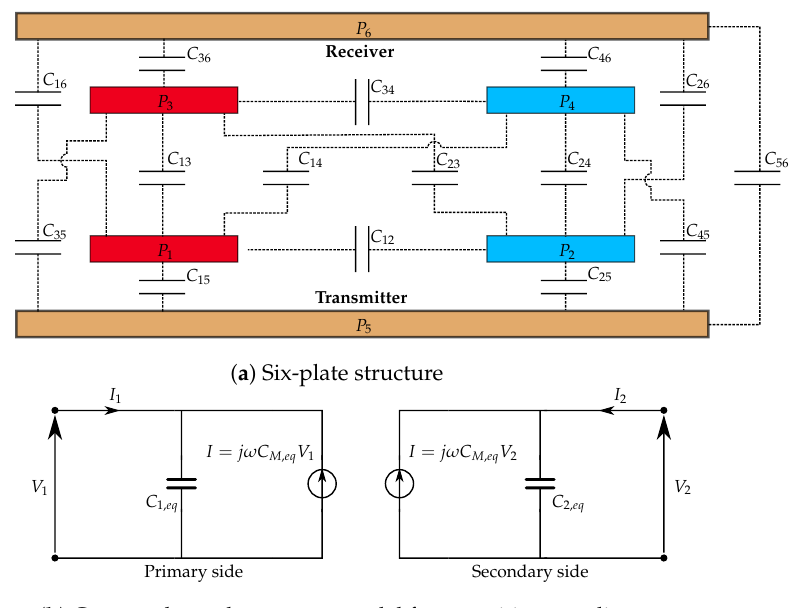
Figure 7. Six-plate structure capacitive coupling model and current-depended source model repre-